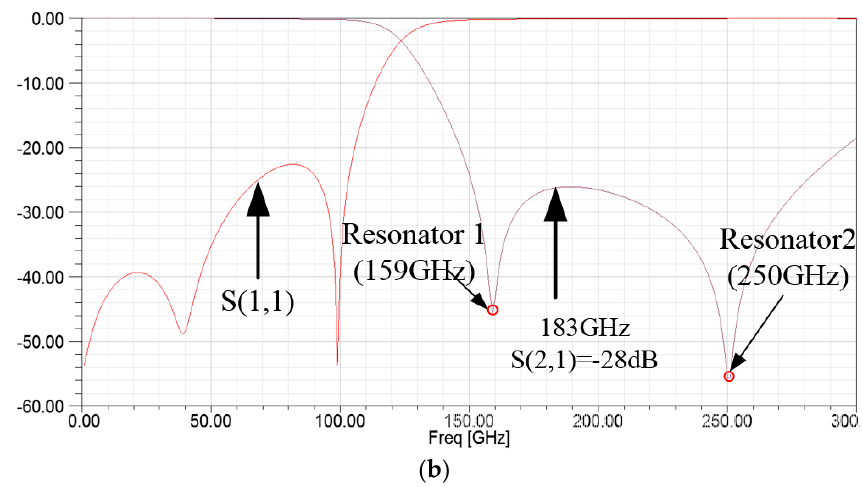
Figure 3. ( a ) Structure of the grounding low-pass filter (LPF) and local oscillator (LO) LPF. ( b ) Simulation performance of the grounding LPF and LO LPF.